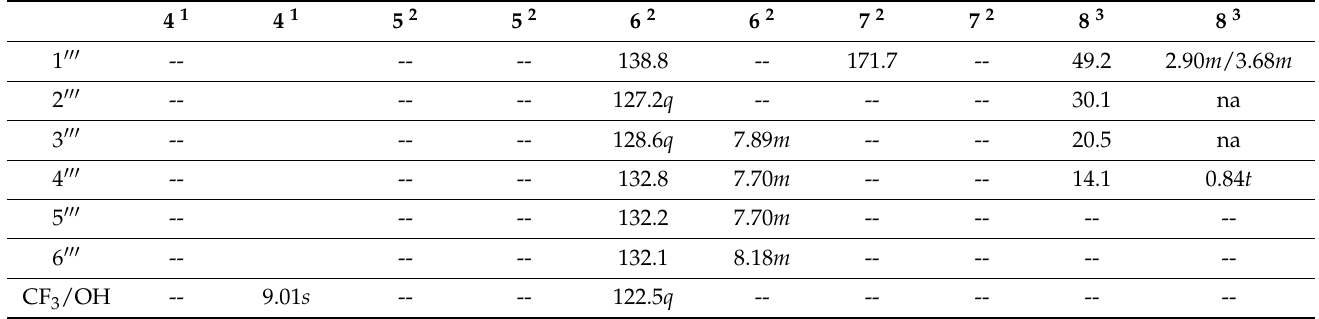
Inhibitor 3: For the irreversible 17 β -HSD1 inhibitor 3 , the only difference with com- pound 2 is the replacement of the OH at C3 of steroid A-ring by a short 2-bromoethyl side chain. The spectral data are, therefore, identical for B, C, and D-rings, as well as for the m -carbamoylbenzyl group at C-16 β (Table 1). In 1 H and 13 C NMR, the signals at 3.55/33.9 ppm and 3.06/40.1 ppm, whose HMBC, HSQC, and NOESY spectra analyses allowed the assignment of BrCH 2 -2 (cid:48)(cid:48)(cid:48) and CH 2 -1 (cid:48)(cid:48)(cid:48) , respectively, are key markers. In 1 H NMR, the replacement of OH at C-3 by the bromoethyl chain caused a deshielding effect on the three CH of A-ring (+0.52, 0.50, and 0.16 ppm for CH-4, CH-2, and CH-1, respectively). In 13 C NMR, a strong shielding effect is observed on ipso C-3 ( − 18.2 ppm), while non- significant effects are observed on meta-positioned C-1 and C-5. For C-2 and C-4 located in ortho, the deshielding effect is significant (+14.5 and 15.2 ppm, respectively), while the effect is weaker (+9.6 ppm) for the C-10 in para. Inhibitor 4: For the 17 β -HSD2 inhibitor 4 , the 13 C NMR data of A and B-rings (Table 2) are identical to those of E2 (Table 1); however, the introduction of a spiro- δ -lactone at position C-17 affects the chemical shifts of the D-ring. As expected, the most affected carbon is C-17 (92.4/+12.4 ppm), while C-13, C-16, and C-18 are less affected ( − 3.9, 3.5, and 2.9 ppm, respectively). Conversely, a deshielding effect was observable for C-12 (+5.1 ppm) and C-14 ( − 3.0 ppm). From the singlet easily attributable to CH 3 -18 (0.90 ppm) and thanks to the correlations observed in the HMBC and HSQC spectra, it was possible to confirm the chemical shifts of CH 2 -12 ( 3 J ), CH-14 ( 3 J ), C-17 ( 3 J ) and C-13 ( 2 J ). Four new signals were also present in the 13 C NMR spectrum, namely the carbonyl characteristic of a lactone (171.1 ppm), as well as three methylene groups. Using the carbonyl signal (C-4 (cid:48)(cid:48) ) and the correlations in the HMBC and COSY spectra, it was possible to assign these last signals as CH 2 -1 (cid:48)(cid:48) , 2 (cid:48)(cid:48) , and 3 (cid:48)(cid:48) . Inhibitor 5: For the 17 β -HSD5 inhibitor 5 , there are two main structural differences compared to inhibitor 4 discussed above. The first, in the right portion of the molecule, is due to the presence of two methyl groups on the C-3 (cid:48) in alpha to the carbonyl of the spiro- δ -lactone. These two CH 3 appear as a singlet at 1.28 ppm in 1 H NMR and two signals at 27.5 and 27.8 ppm in 13 C NMR (Table 2). Their presence causes a deshielding effect at C-4 (cid:48)(cid:48) (177.8/+6.7 ppm), C-3 (cid:48)(cid:48) (37.8/+8.8 ppm), and C-2 (cid:48)(cid:48) (34.8/+19.5 ppm). The second difference, in the left portion of the molecule, is due to the replacement of the OH at C3 by an H to obtain a deoxygenated steroid A-ring. This modification is easily confirmed by the presence of a new aromatic CH whose chemical shifts (7.13 and 125.2 ppm) in 1 H and 13 C NMR are identical to those of CH-1 and CH-2. Inhibitor 6: For the 17 β -HSD3 inhibitor 6 , the basic nucleus is E1 (17-C=O), unlike that of E2 (17 β -OH) used for the other inhibitors and the activator. The comparison of 13 C NMR data (Table 2) for C and D-rings is, therefore, in agreement with those reported in the literature for E1 [43]. A functionalized side chain linked at position C-3 of the steroid by an amide bond influences the chemical shifts of the A-ring signals, mainly in 13 C